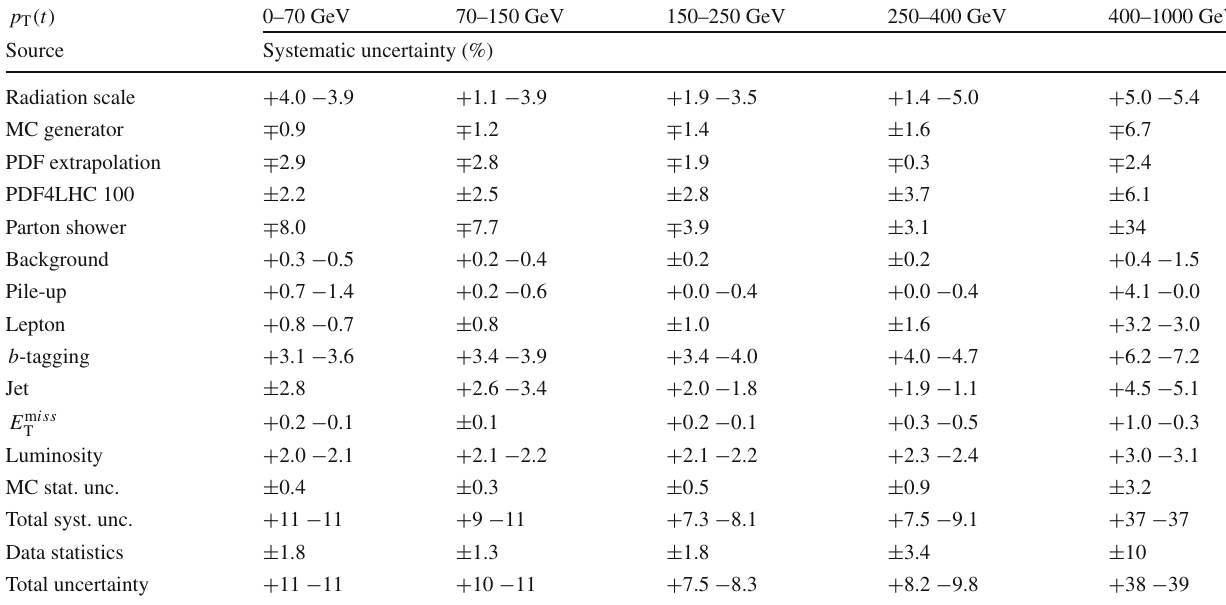
Table 2 Summary of the sources of uncertainty in the absolute fiducial differential cross-section as a function of p T ( t ) . The uncertainties are presented as a percentage of the measured cross-section in each bin. Entries with 0.0 are uncertainties that are less than 0.05 in magnitude.